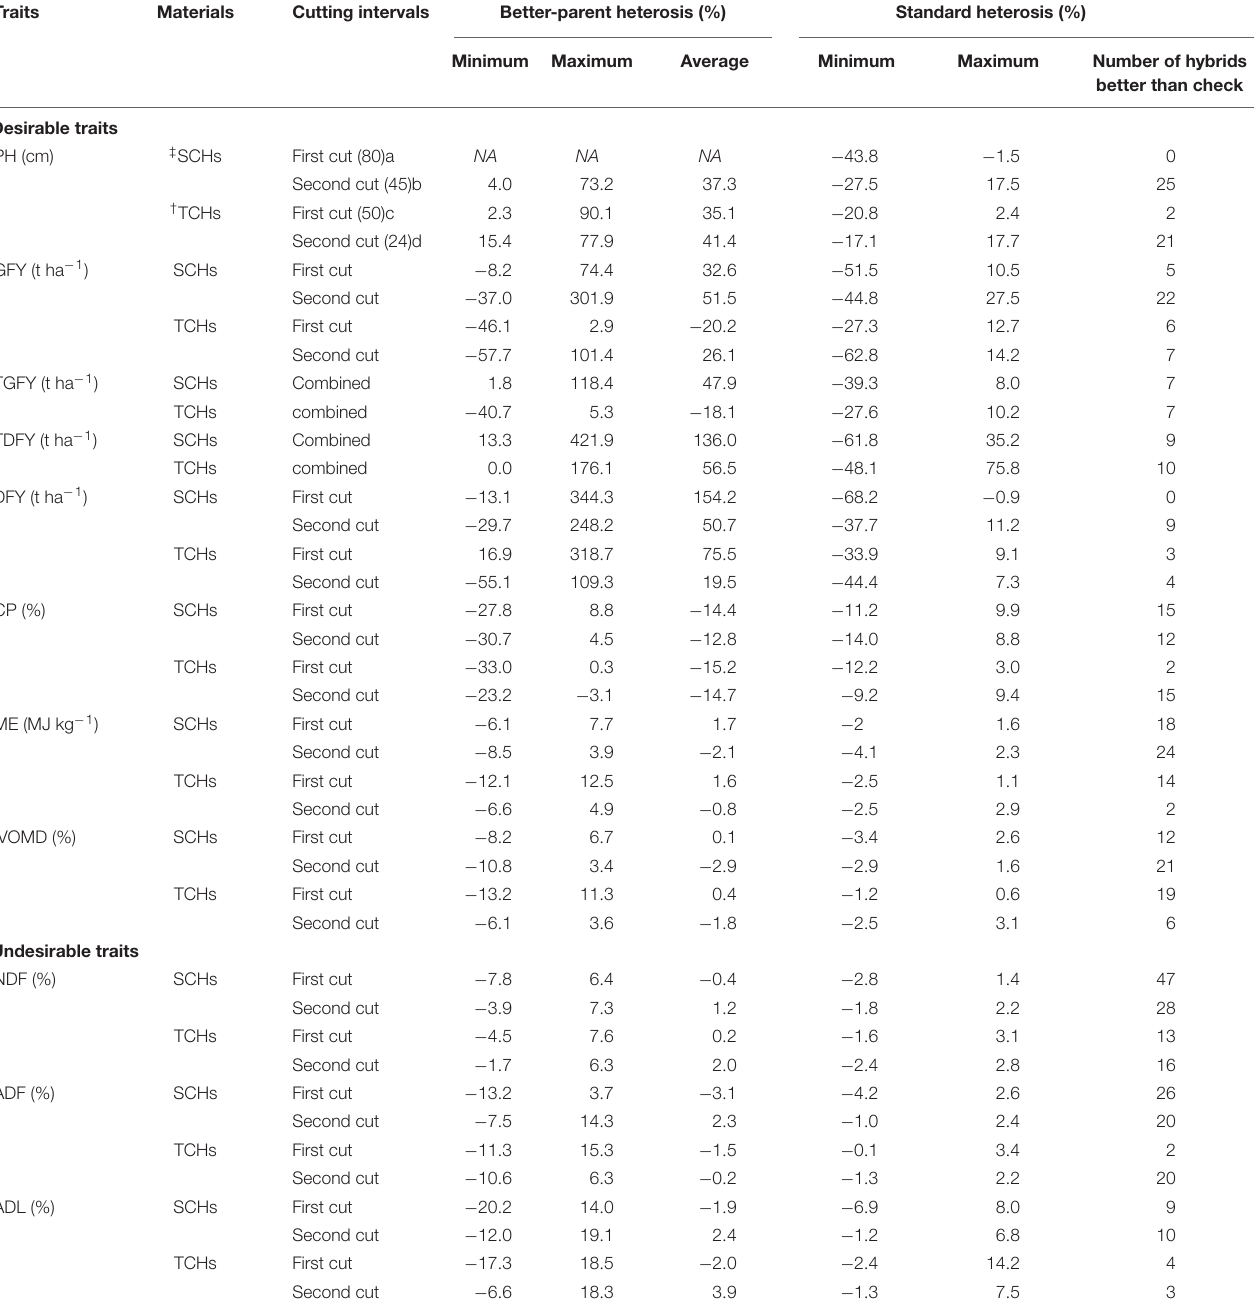
TABLE 2 | Heterosis for the forage linked morphological and biochemical traits in SCHs and TCHs evaluated in summer season of 2015 at ICRISAT, Patancheru, and TNAU, Coimbatore. Traits Materials Cutting